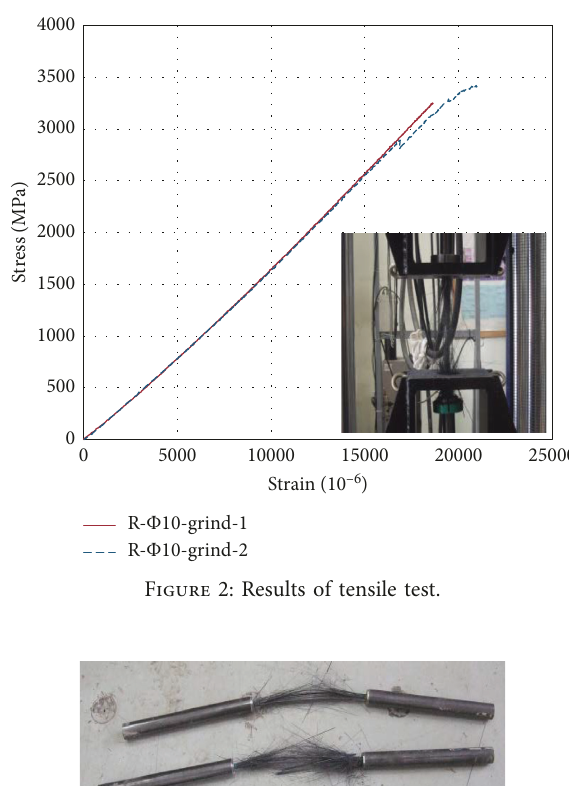
Figure 3: Rupture of CFRP